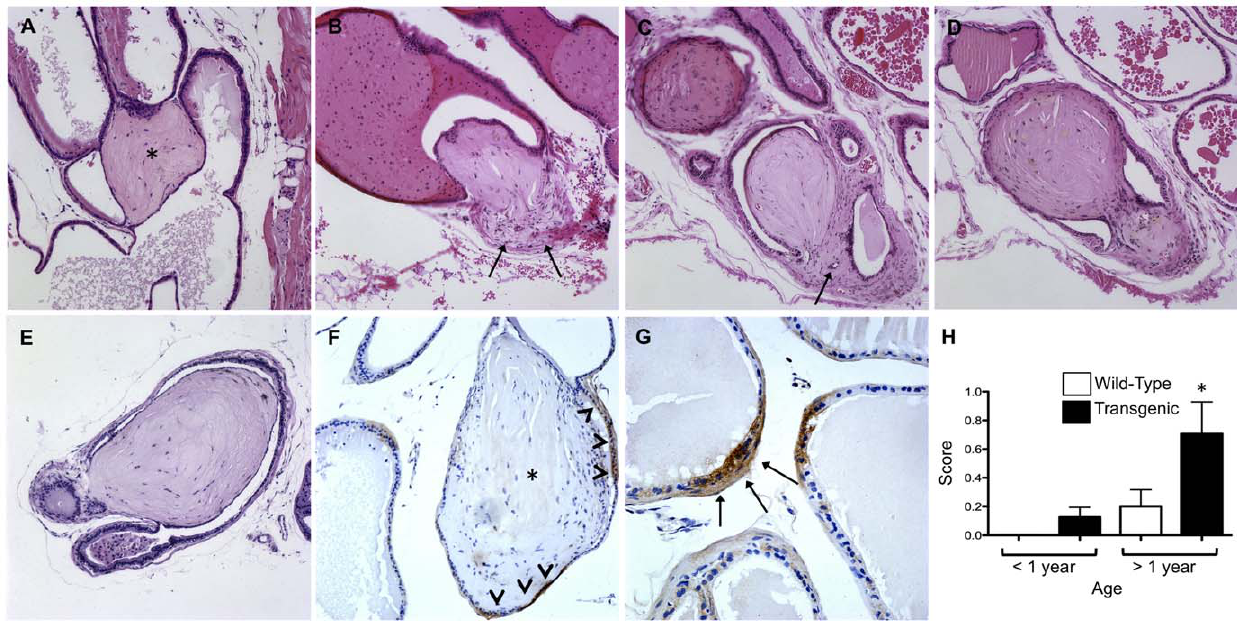
Figure 5. Collagenous micronodules in TGF- b 1 transgenic mice. PanelA . Micronodules originate from the stroma immediately adjacent to epithelial acini (asterisk). PanelB . Micronodules are associated with a fibroplastic reactive stroma at their base (arrows) and project into the wall of epithelial acini. PanelC. Periacinar stroma is thickened in regions adjacent to micronodules. Vessels are often observed at the base of stromal micronodules (arrow). PanelDandE. Larger stromal nodules show greater deposition of matrix and project fully into the lumen of collapsed atrophic acini. PanelF . In certain cases, a collagenous micronodule (asterisk) appears adjacent to regions of transgene expression in the epithelial layer (arrowheads: IHC for HA epitope). PanelG. Focal immunoreactivity for HA epitope can be observed in epithelium adjacent to regions of periacinar stromal thickening in transgenic mice. PanelH. A significant elevation in general fibroplasia is noted in transgenic mice over one year of age as compared to age-matched wildtype controls and transgenic mice under one year of age (* P , 0.05). Images A–F captured at 6 200 magnification and image G at 6 400.